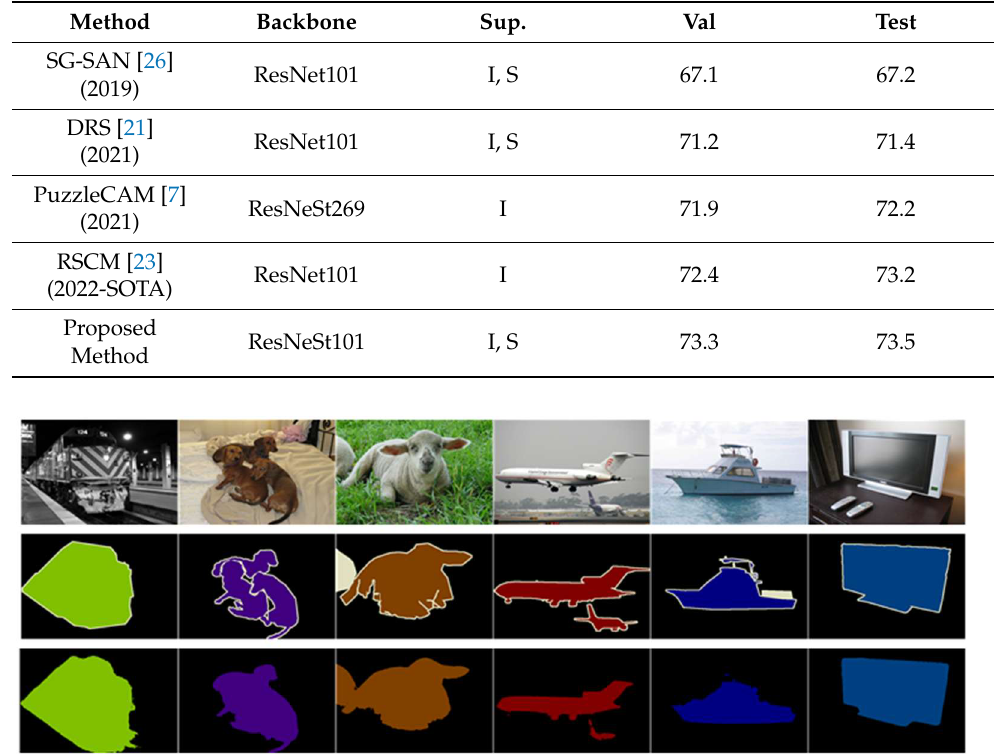
Figure 6. Segmentation results on PASCAL VOC 2012 validation dataset. Top: original images; Middle: ground truth, and Bottom: prediction results.